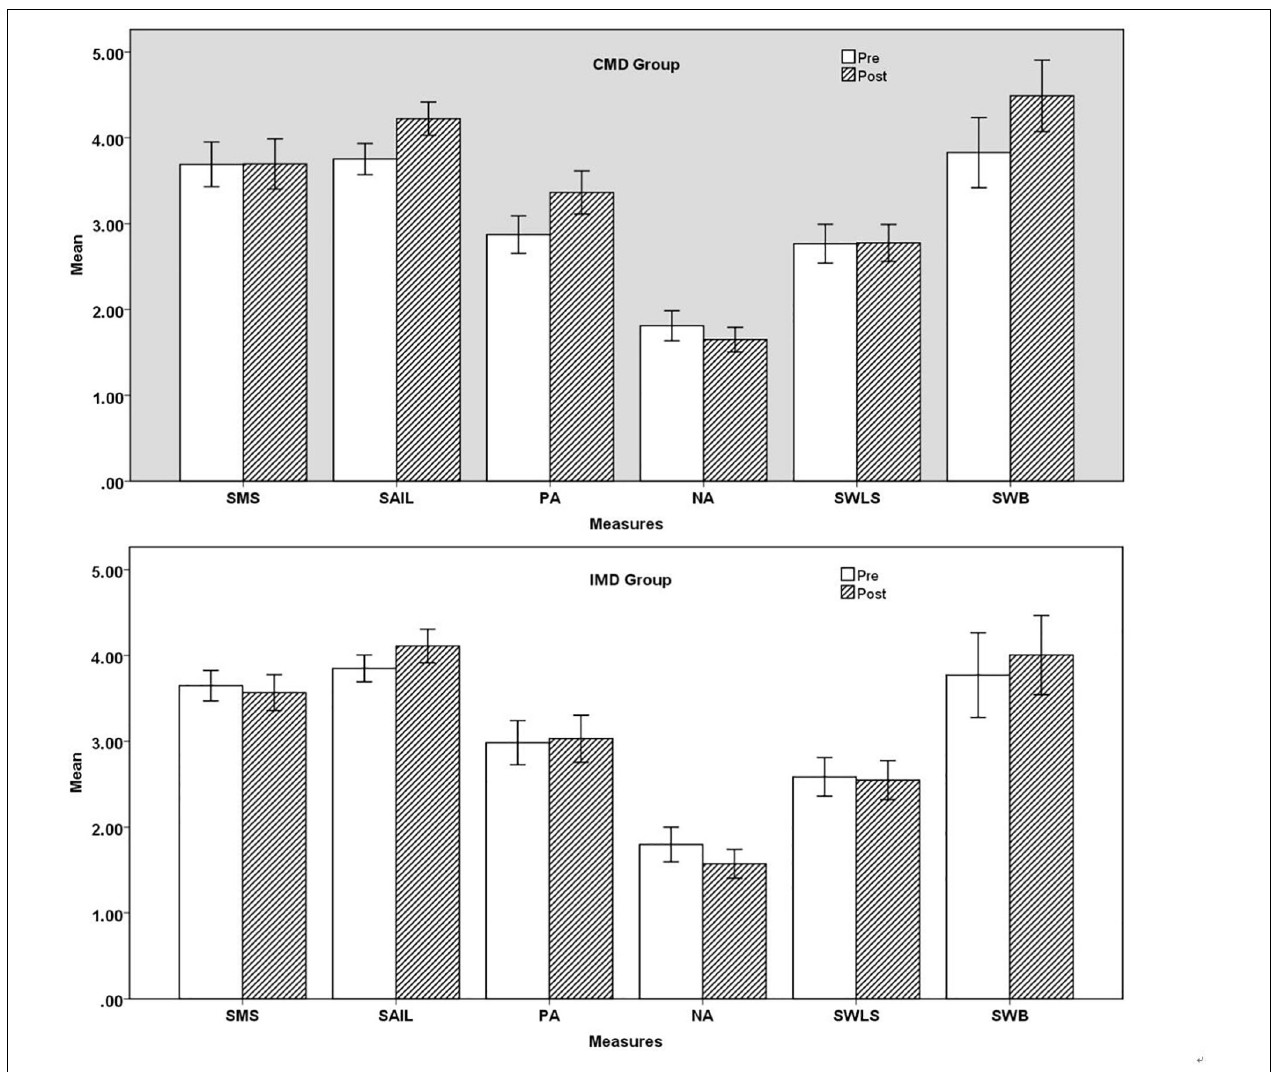
FIGURE 2 | Comparison of six scales between IMD and CMD. SMS, State Mindfulness Scale; SAIL, Spiritual Attitude and Involvement List; SWB, subjective well-being; PA, positive affect; NA, negative affect; SWLS, Satisfaction With Life